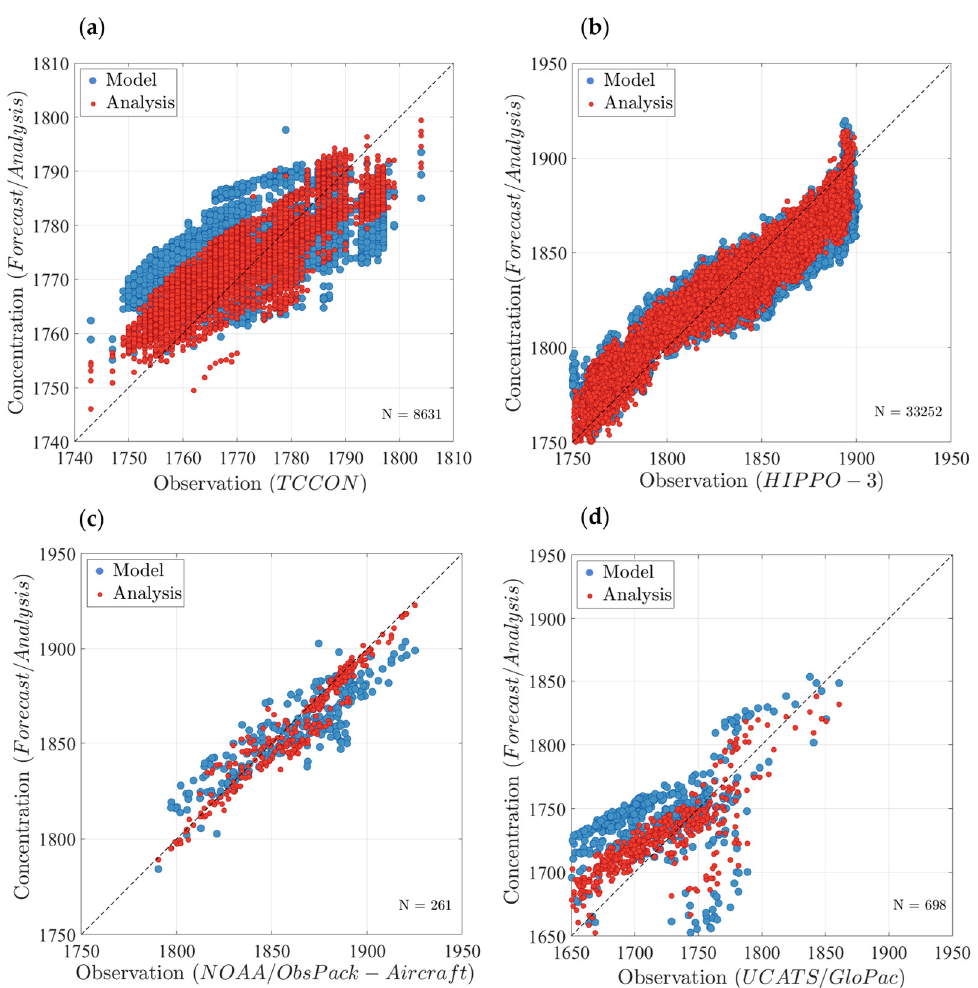
Figure 9. Comparison between the model forecast (blue circles) and analysis with GOSAT assimila- tion (red circles) sampled at four types of independent measurements, including ( a ) TCCON, ( b ) HIPPO-3, ( c ) NOAA/ObsPack aircraft, and ( d ) UCATS/GloPac. N denotes the number of observations of each type.